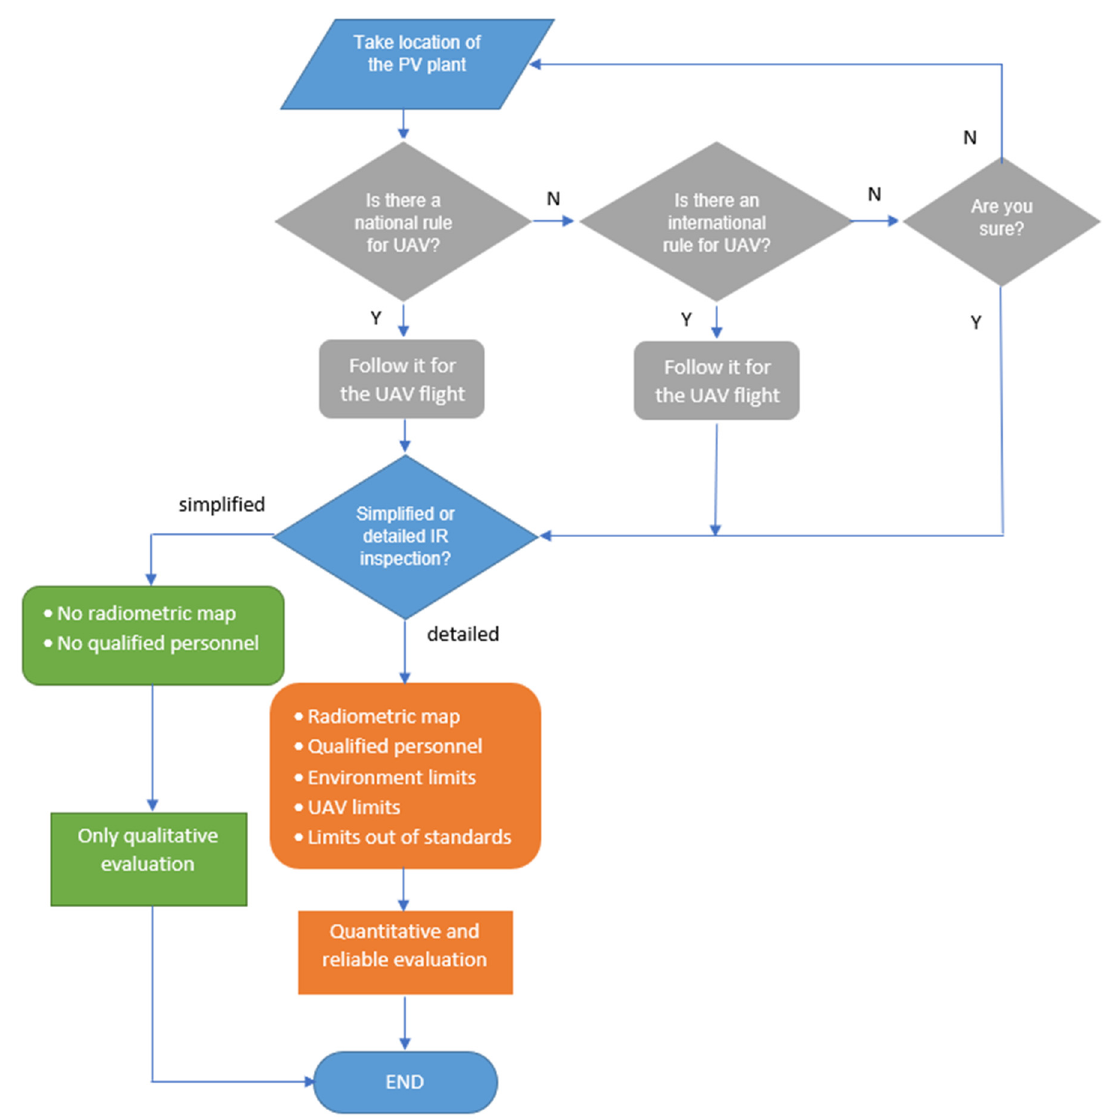
Figure 3. Methodology for the reliable IR inspection of a PV module with a